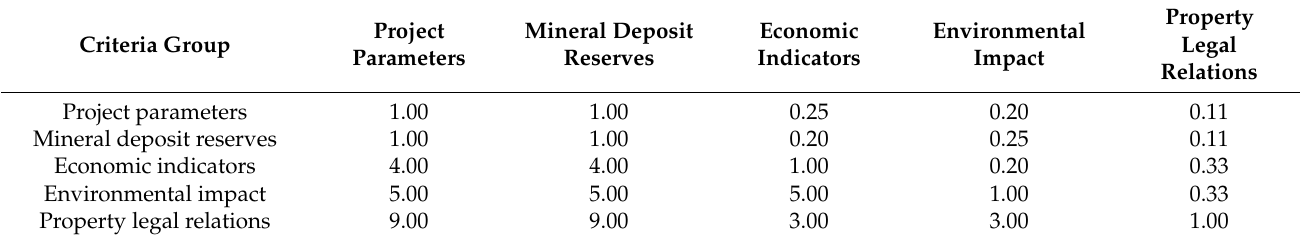
Table 4. Comparison matrix of main groups of criteria.